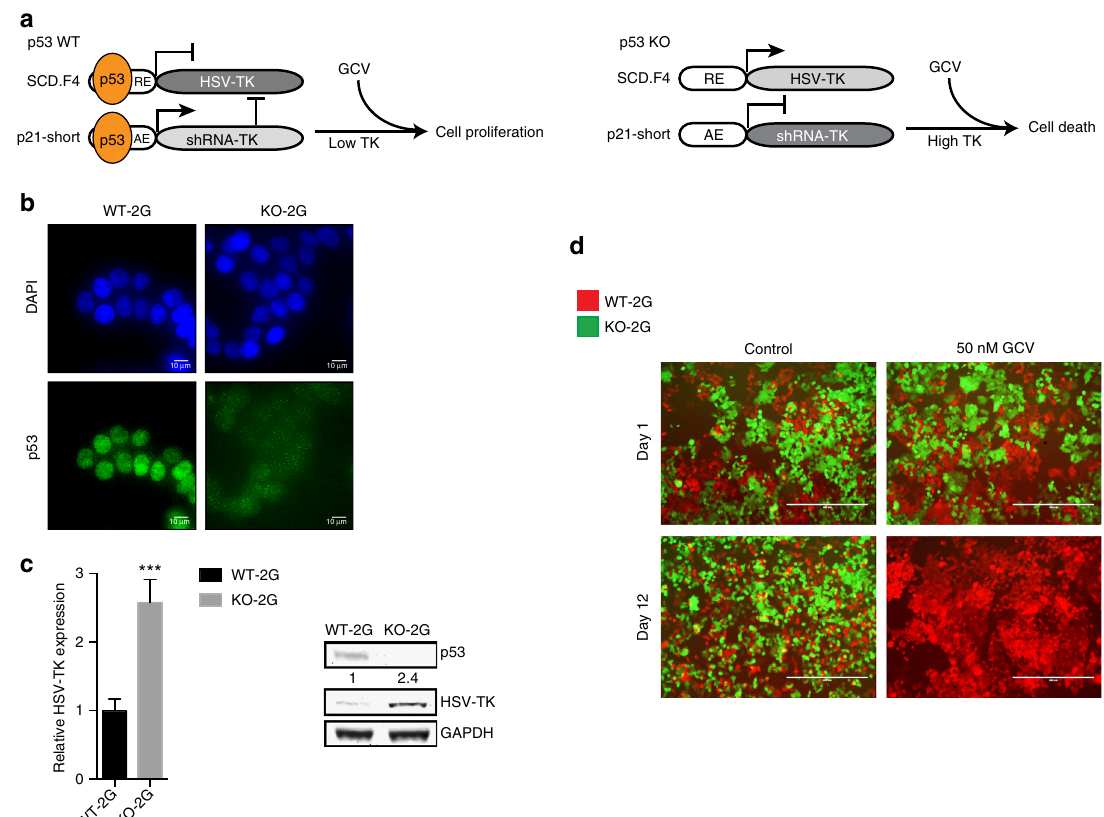
Fig. 2 The 2G sensor can discriminate between p53 WT and KO cells and sensitizes KO cells to GCV. a Schematic outline of the 2G sensor with HSV-TK as a primary output and cellular outcomes after GCV treatment in p53 WT and KO cells. b Representative immuno fl uorescence (IF) images of DAPI (top panel) and p53 antibody-stained (bottom panel) WT-2G and KO-2G cells. Scale bars depict 10 μ m. c Comparison of relative HSV-TK expression between WT-2G and KO-2G cells on either mRNA level by qPCR (left) or on protein level by Western blot (right). Error bars depict SD of three independent experiments and Student ’ s two-tailed t -test values are given (*** P < 0.001). The relative quanti fi cation of the HSV-TK band signals is provided. d Representative images of the two-color assay in which a mix of WT-2G (mCherry-tagged) and KO-2G (GFP-tagged) cells was either treated with 50 nM GCV or control (water) for indicated period of time. Scale bars represent 400 μ